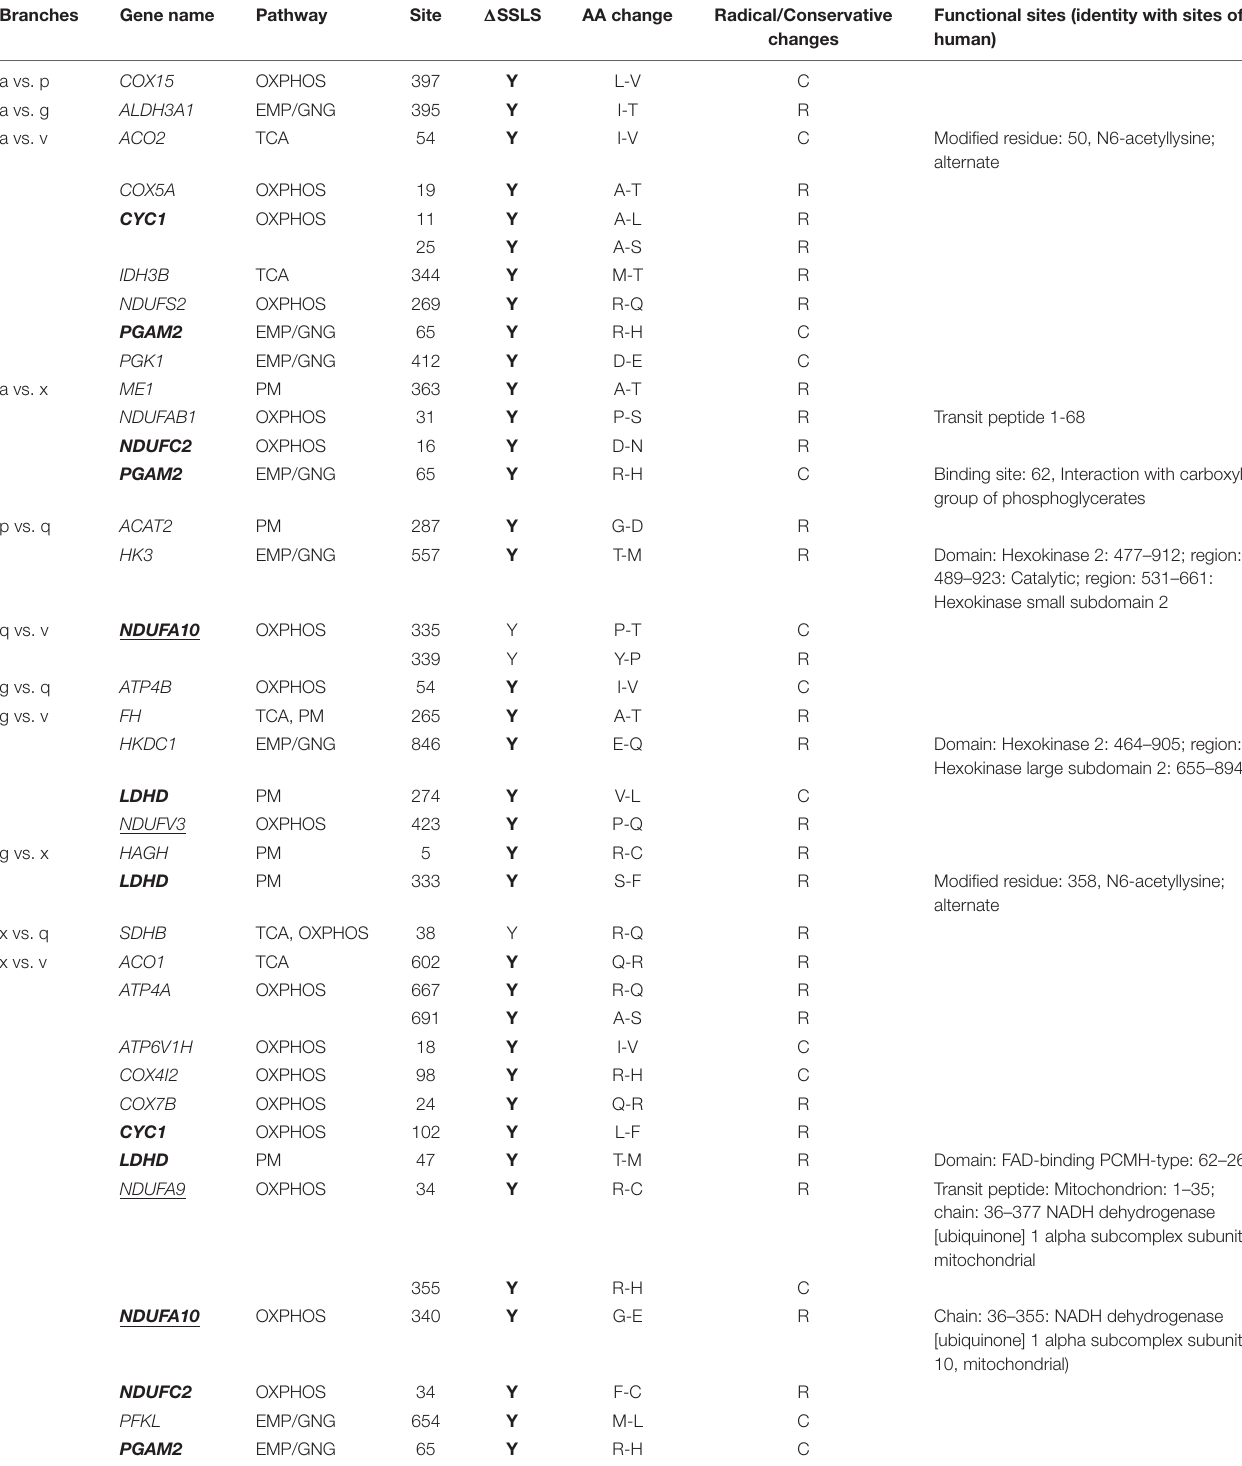
TABLE 2 | Thirty-eight parallel amino acid substitutions in 29 genes in hypoxia-tolerant species.